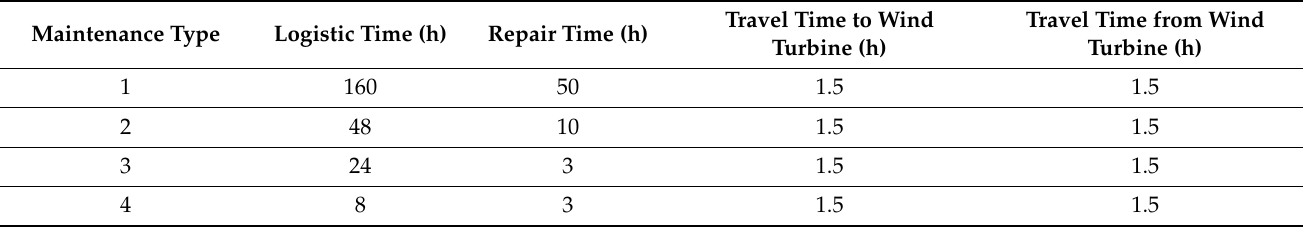
Table A3. Maintenance parameters for floating offshore wind turbines